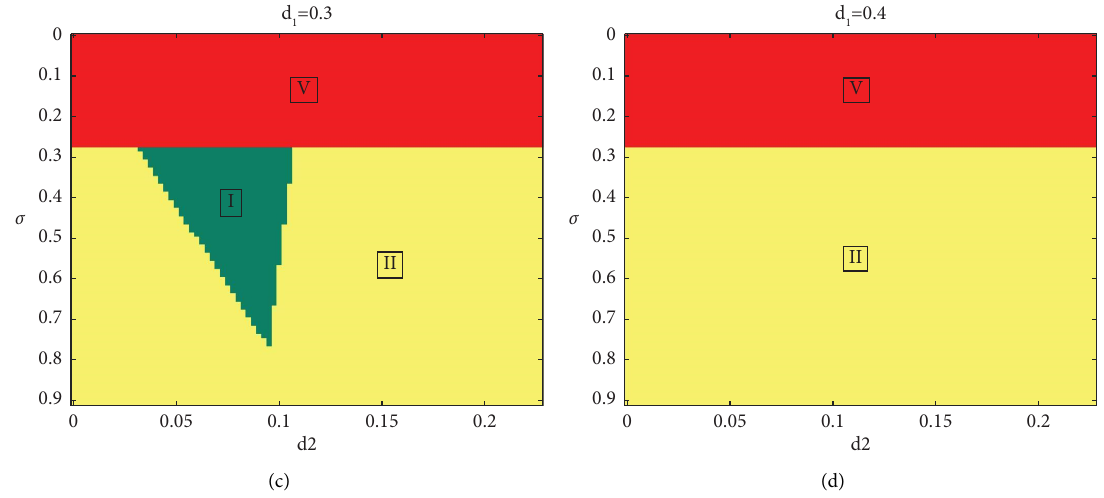
Figure 8: ( a ) , ( b ) , ( c ) , ( d ) are parameter planes of M with respect to d � 0 . 2 in (b), d � 0 . 3 in (c), d � 0 . 4 in (d). Te results show that M < 1 in region I and M > 1 in regions II and in (a), d 1 1 1